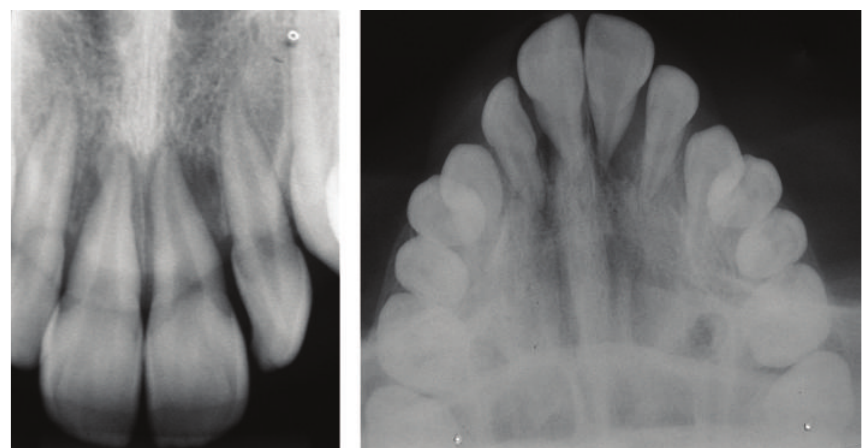
Figure 2: Initial radiographic findings.